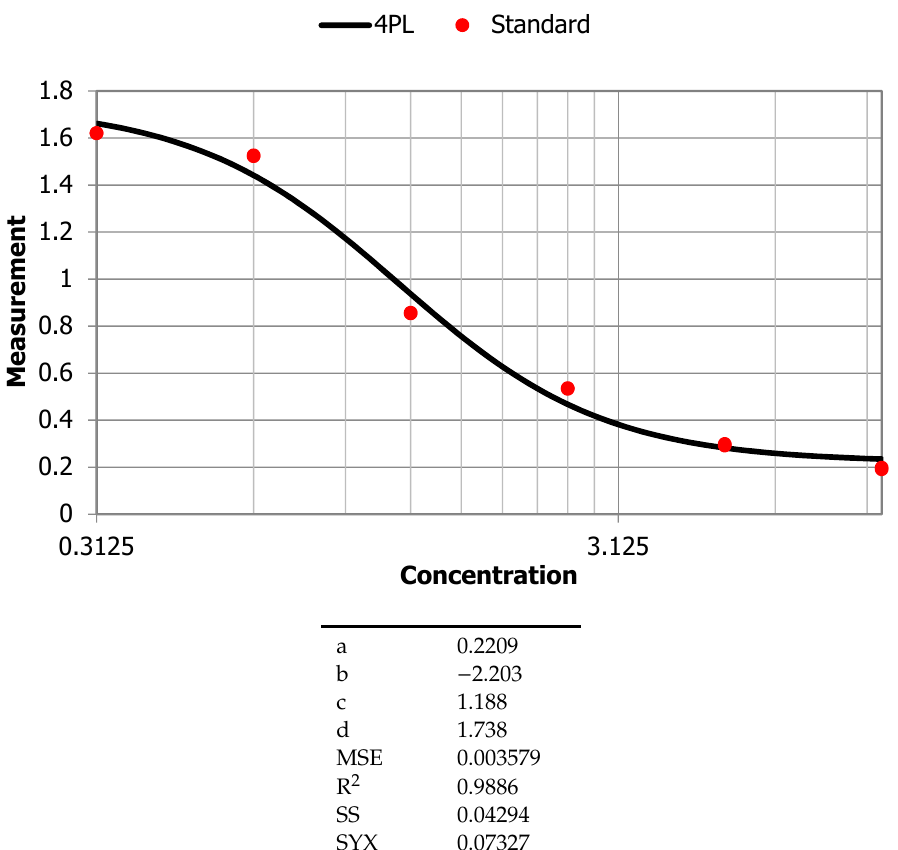
Figure A1. Anti-PLA 2 R ELISA standard FigureA1. Anti-PLA 2 R ELISA standard curve.